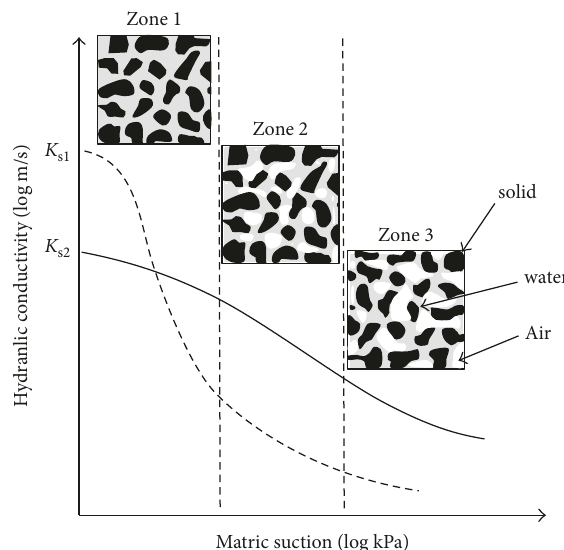
Figure 4: The general scheme of the matric hydraulic conductivity- matric suction curve for different types of soil.